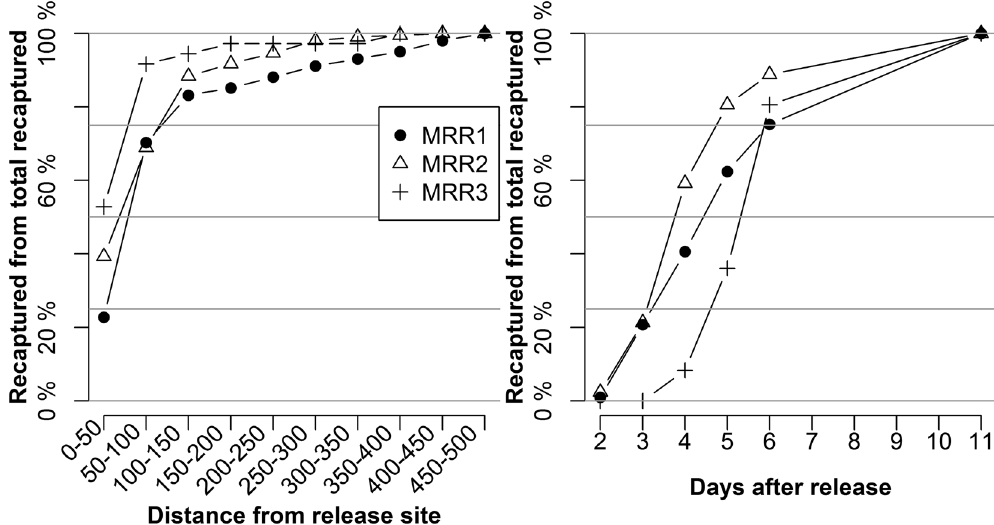
Figure 2. Cumulative proportion of recaptured Aedes albopictus females on total of recaptured across the study area ( A ) and during the first 11 days after release ( B ), in the three mark-release-recapture experiments (MRR1, MRR2 and MRR3).